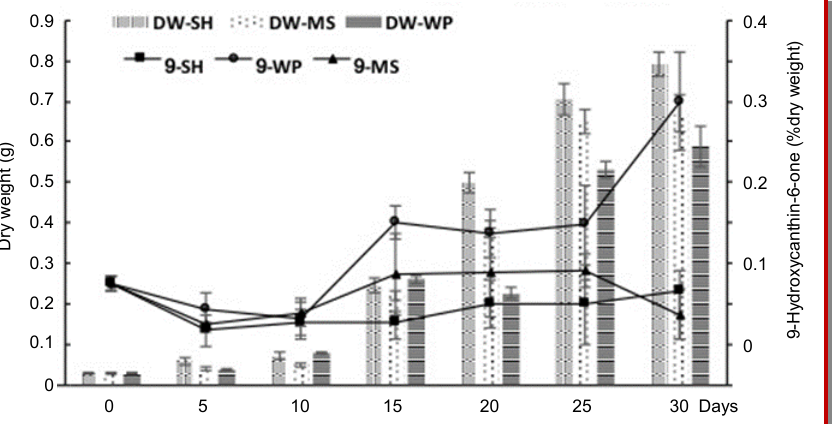
Figure 1: Dry weight and 9-hydroxycanthin-6-one production in hairy root of E. longifolia on different basal media (MS, SH, and WP). The mean ± SD data from three independent experiments are